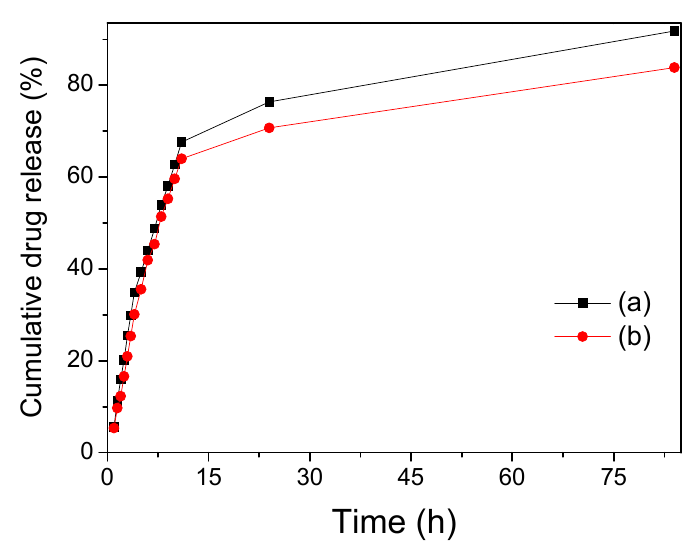
Figure 6. Drug release curves of (a) Fe 3 O 4 /SiO 2 core-shell composite nanospheres and (b) Fe 3 O 4 /SiO 2 /PPy core-shell composite nanospheres under stirring.